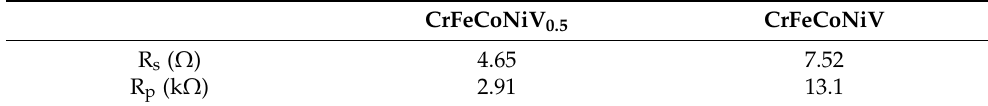
Figure 7. Electrochemical impedance spectroscopy measurements of as-cast CrFeCoNiV x alloys in 1M HCl solution: ( a ) Nyquist plots; ( b ) Bode plots; ( c ) corresponding equivalent circuit diagrams. R s is the solution resistance; R p is the polarization resistance; CPE is the constant phase element; W is the Warburg impedance. Table 6. The resistances of as-cast CoCrFeNiV x alloys in deaerated 1M HCl